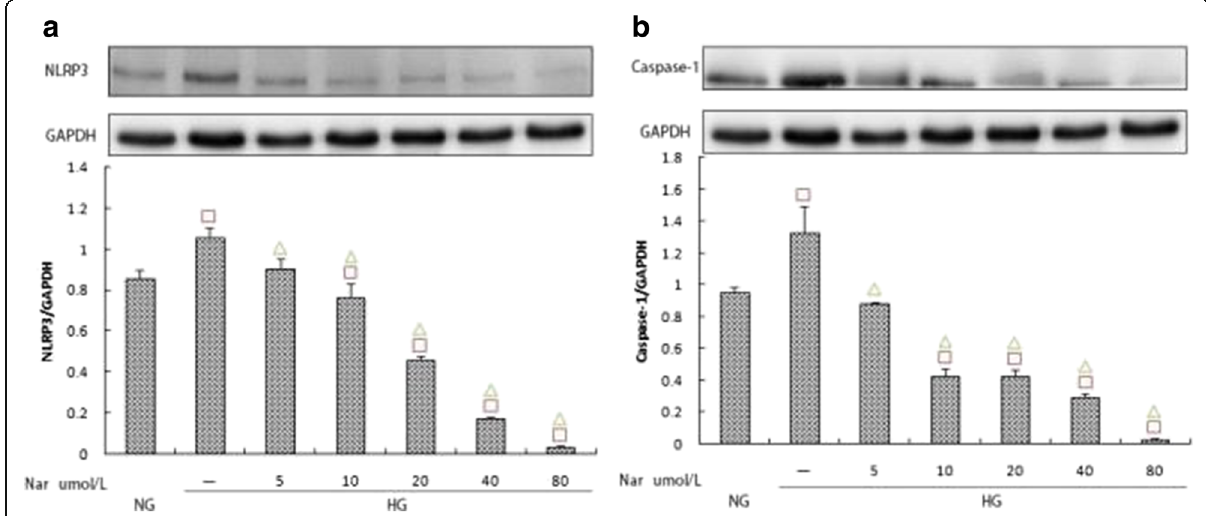
Fig. 8 a , b Effects of different naringin concentrations (0,5,10,20,40 and 80 umol/L) on the expression of NLRP3 and Caspase-1 within the high glucose group. The protein was measured by western blotting.GAPDH was used as an internal loading control. NG:normal control group,HG:high glucose group.Data are presented in mean ± SD, □ P < 0. 05 versus normal control group, △ P < 0. 05 versus high glucose